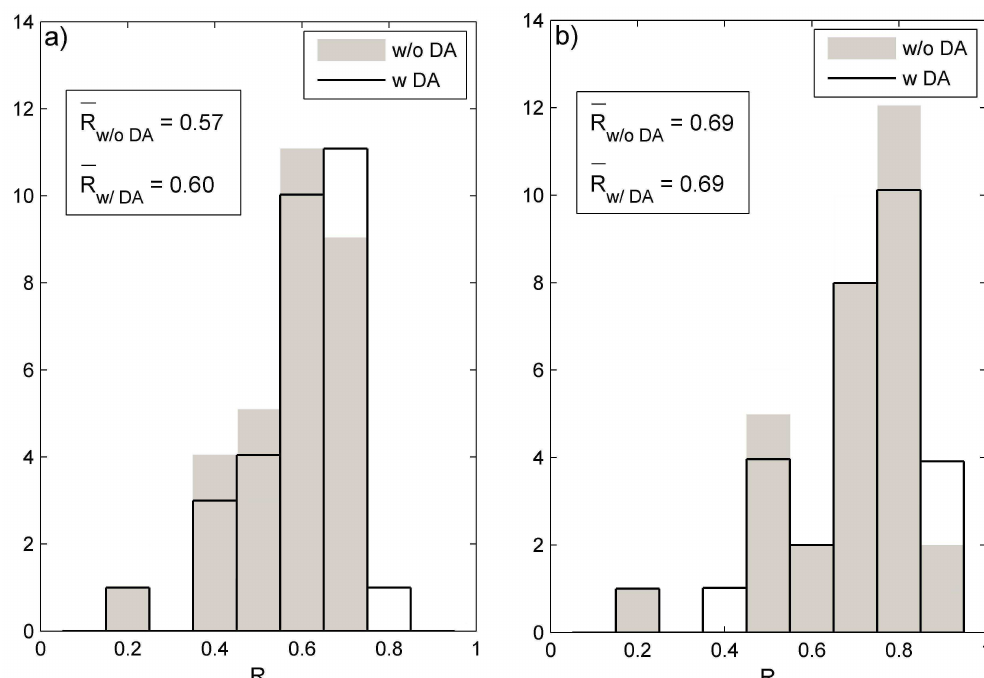
Fig. 4. Histograms of the correlation coefficient ( R ) of the modelled soil water content with in situ SCAN data for: (a) first layer of soil, (b) second layer of soil. The histograms show the difference in the validation with and without the data assimilation (DA) of satellite soil moisture.